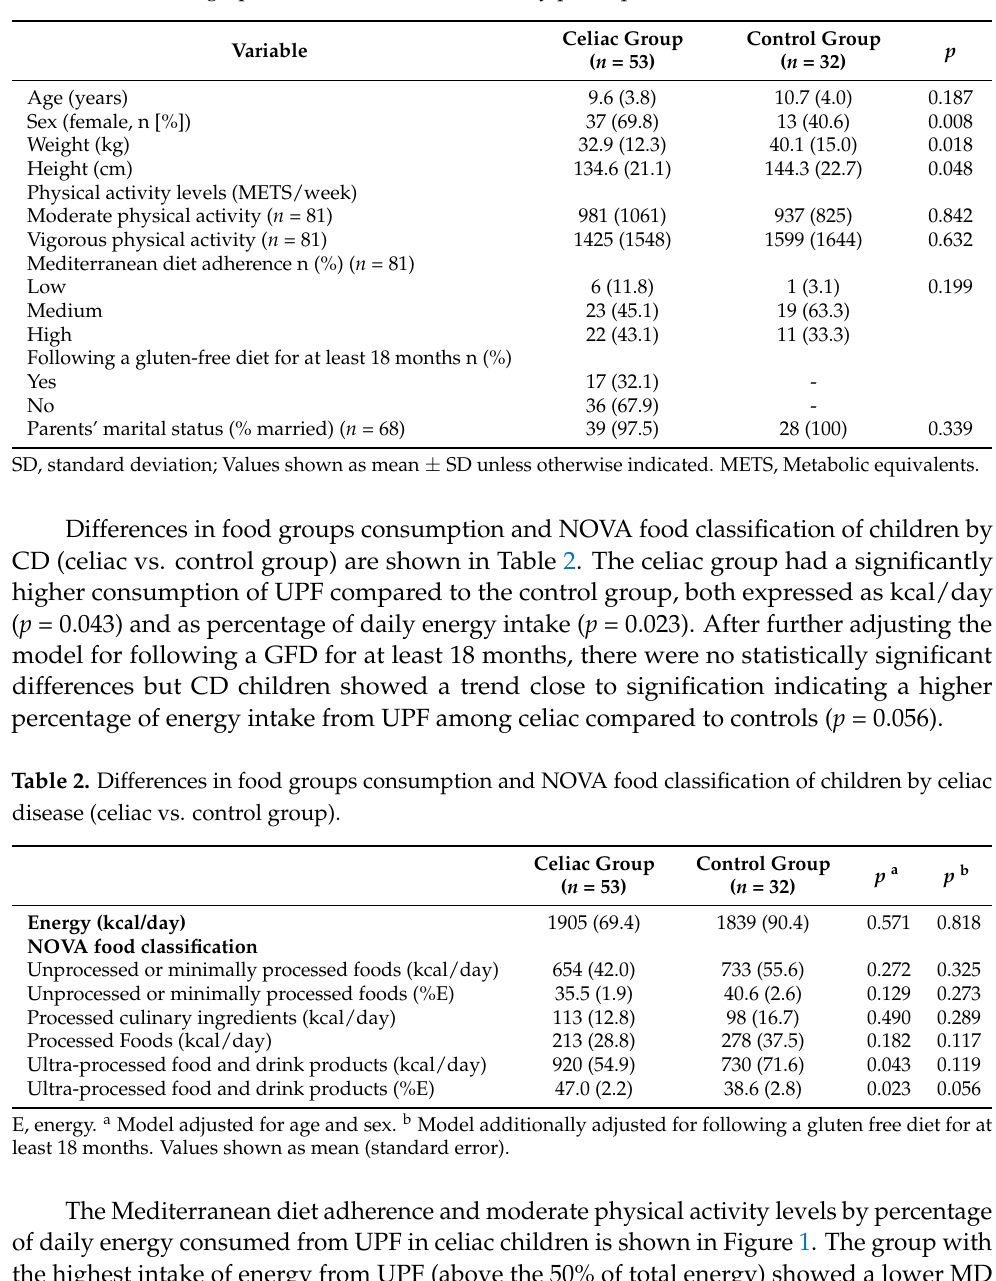
Table 1. Sociodemographic characteristics of the study participants.